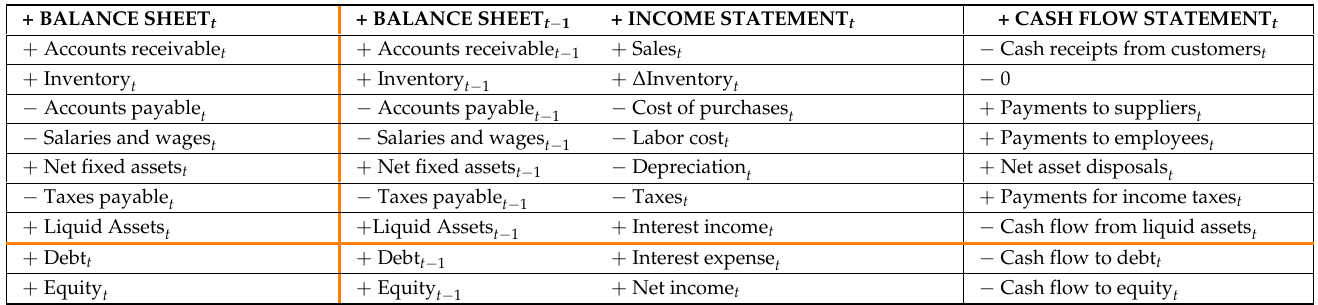
Table 2. The Full-Scale Split-Screen